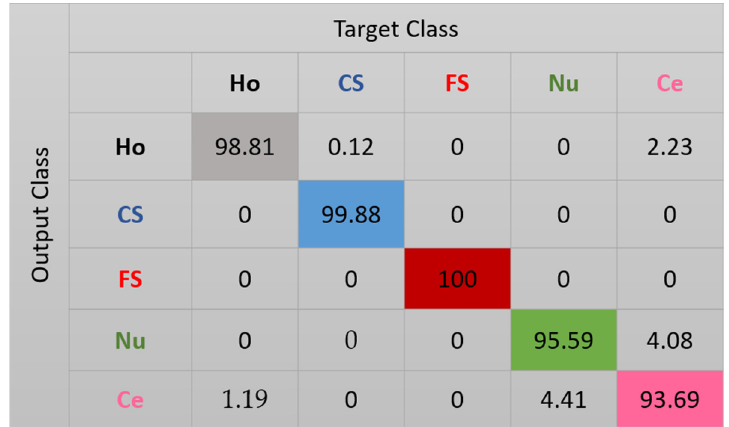
Figure 11. Confusion matrix for case 3. “Ho”, “CS”, “FS”, “Nu”, and “Ce” represent homogeneous, coarse speckled, fine speckled, nucleolar, and centromere cells, respectively.